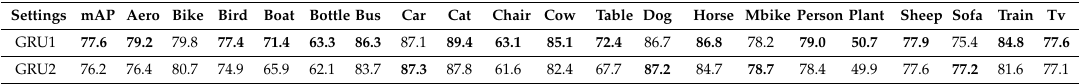
Table 11. Comparison of di ff erent inputs of GRU. The experiments are conducted on PASCAL VOC 2007. All methods are trained on PASCAL VOC 2007 trainval + 2012 trainval. GRU1 represents the inputs are the scene-level information and relationship with objects. GRU2 represents the mixed information. The bold characters represent the best result for each